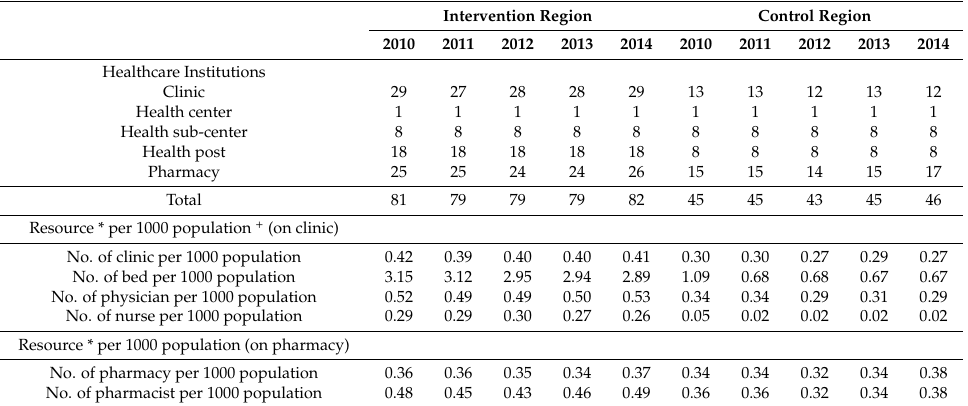
Table 2. Comparison of healthcare resources between study regions: Enabling factors on the Andersen